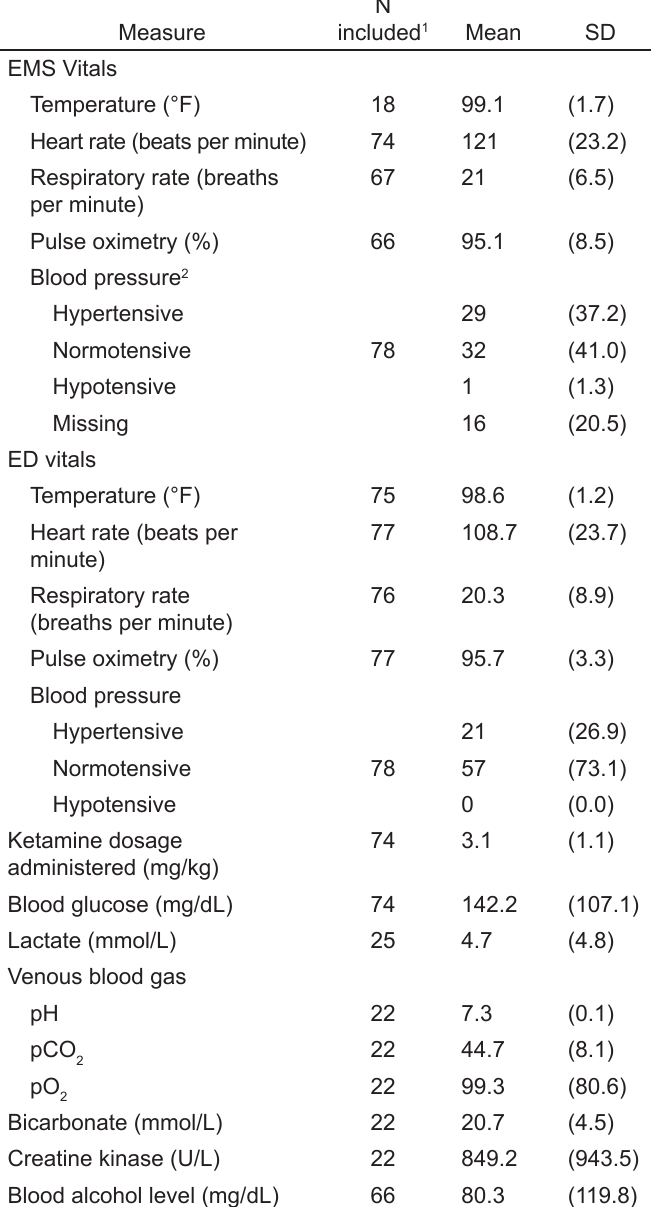
Table 2. Vital statistics and laboratory test values for patients receiving ketamine in the prehospital setting.